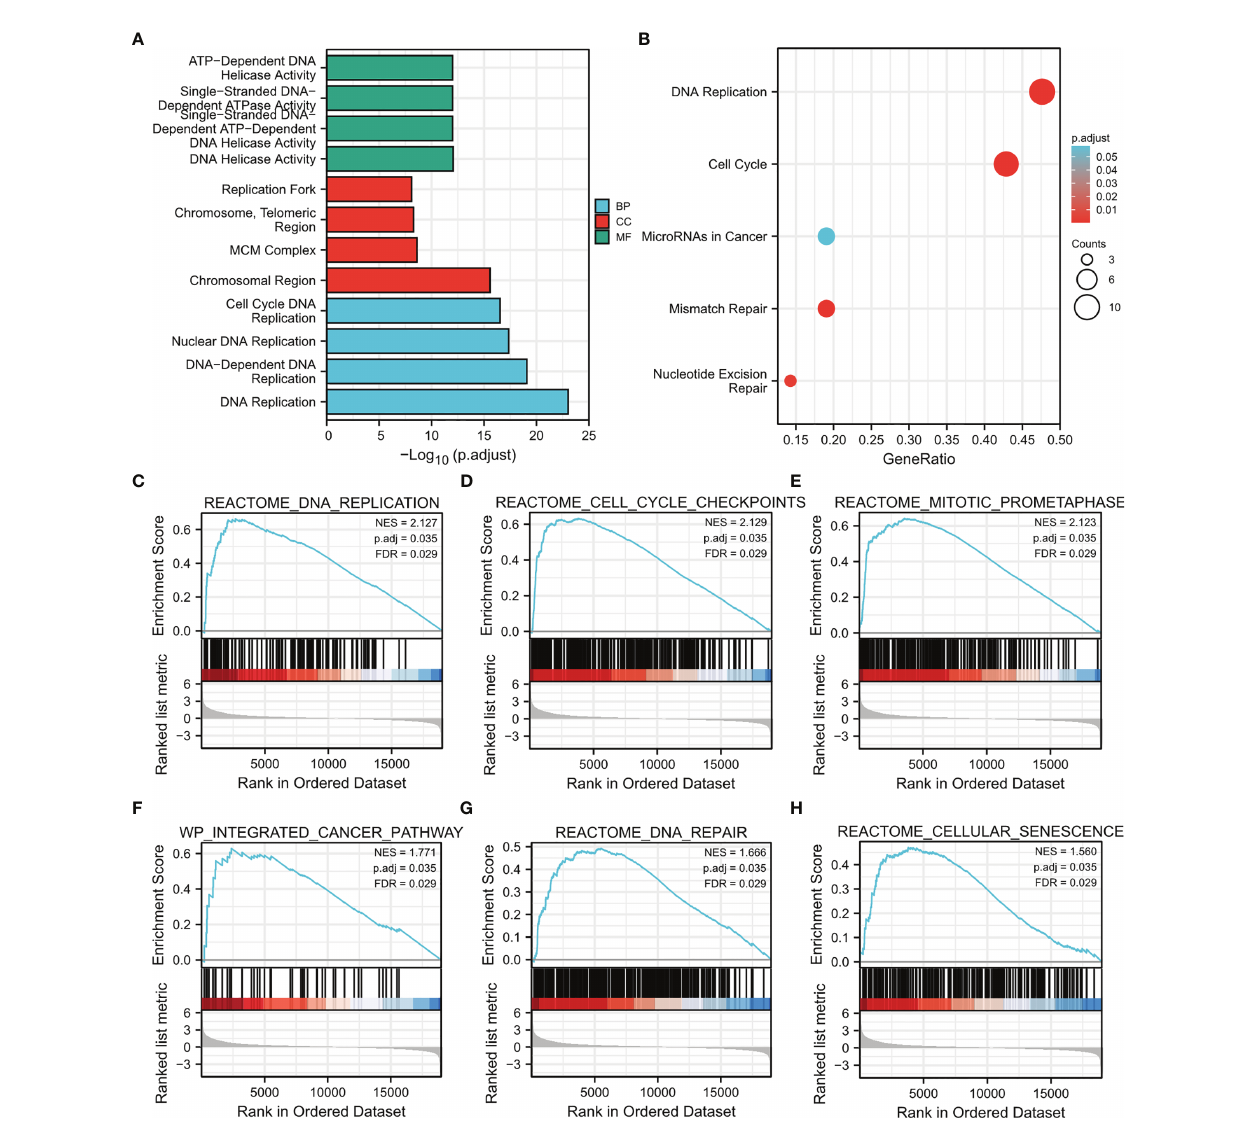
FIGURE 7 | Results of enrichment analysis. (A, B) GO and KEGG enrichment results of CDT1-related DEGs (15 most signi fi cant upregulated and 15 most signi fi cant downregulated genes in HCC samples with CDT1 high and CDT1 low expression). (C – H) Gene set enrichment plots of (C) DNA replication, (D) cell cycle checkpoints, (E) mitotic prometaphase, (F) integrated cancer pathway, (G) DNA repair, and (H) cellular senescence with high CDT1 expression from